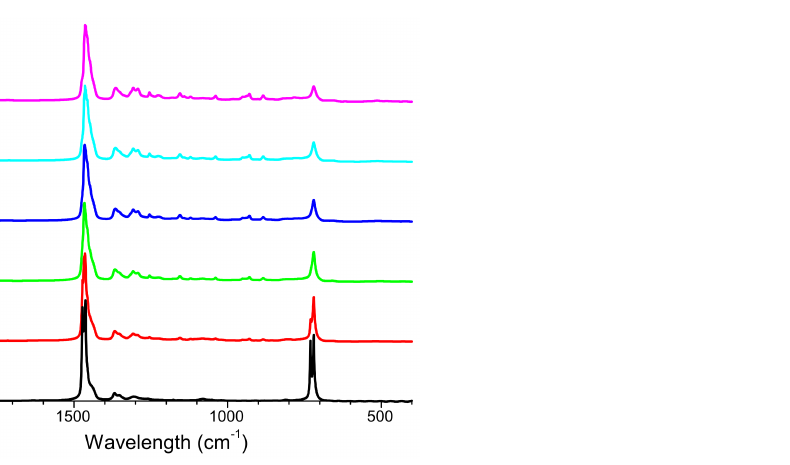
Figure 3. ATR-FTIR spectra for all the samples ( a ), and normalized spectra ranging between 2000 and 400 cm − 1 ( b ).